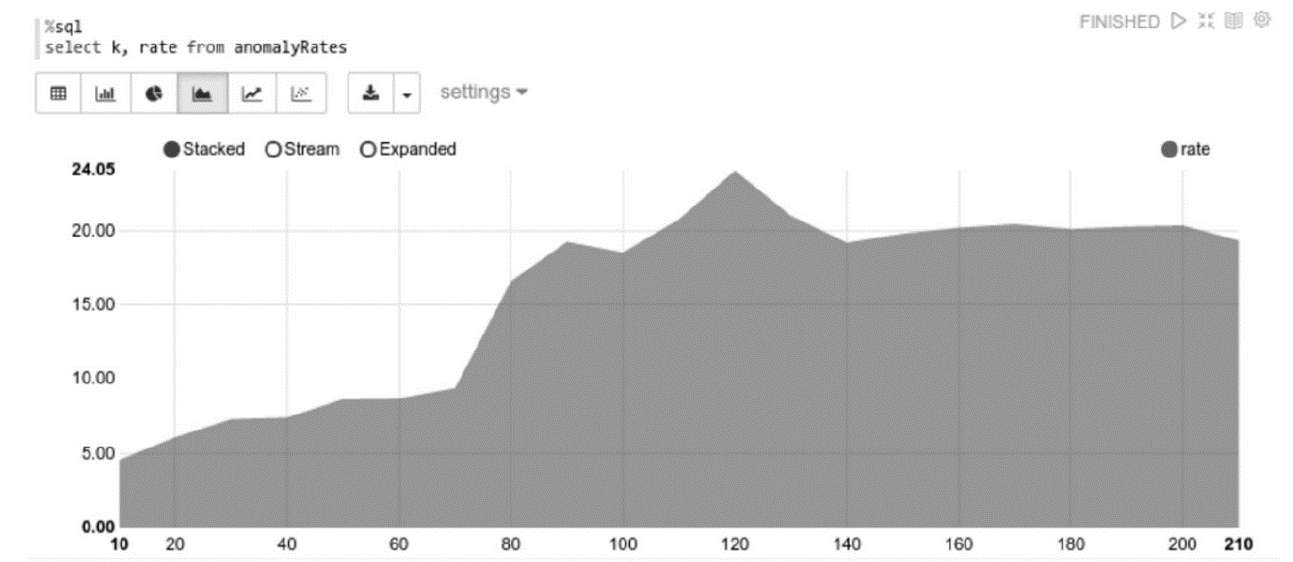
Figure 16. Anomaly rates.